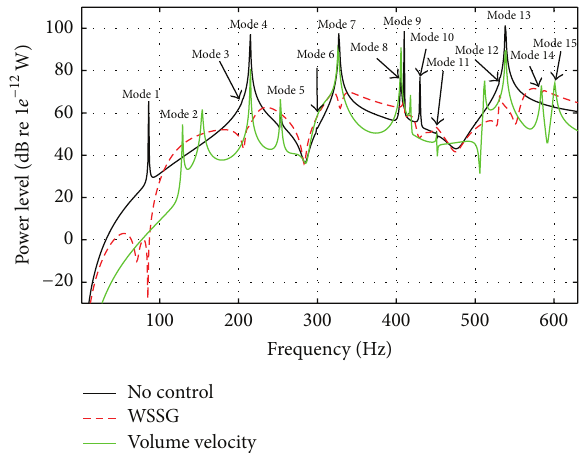
Figure 10: Sound radiated by the third radiation mode on the clamped rectangular